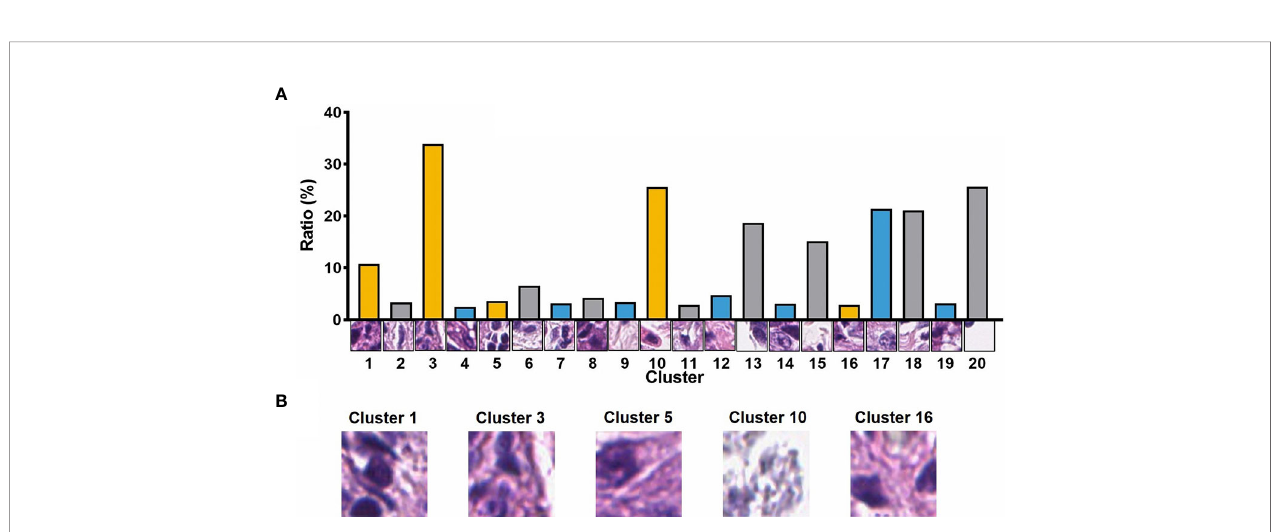
FIGURE 3 | (A) The ratio of 20 PPCR features to all patches; (B) visualization of image patches in fl uencing outcomes of patients.